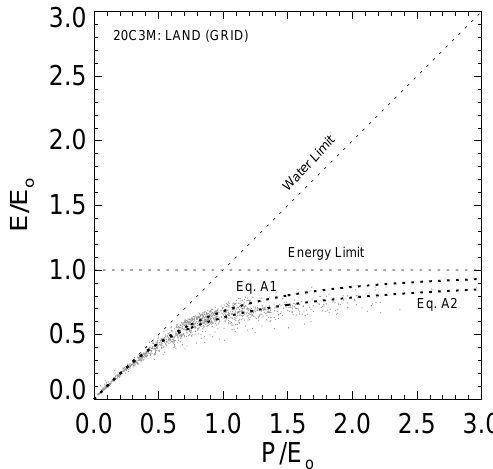
Fig. A1. Comparison of the two alternate forms (Eq. A1 vs. Eq. A2) of the Budyko curve. All else is the same as Fig. 2e in the main